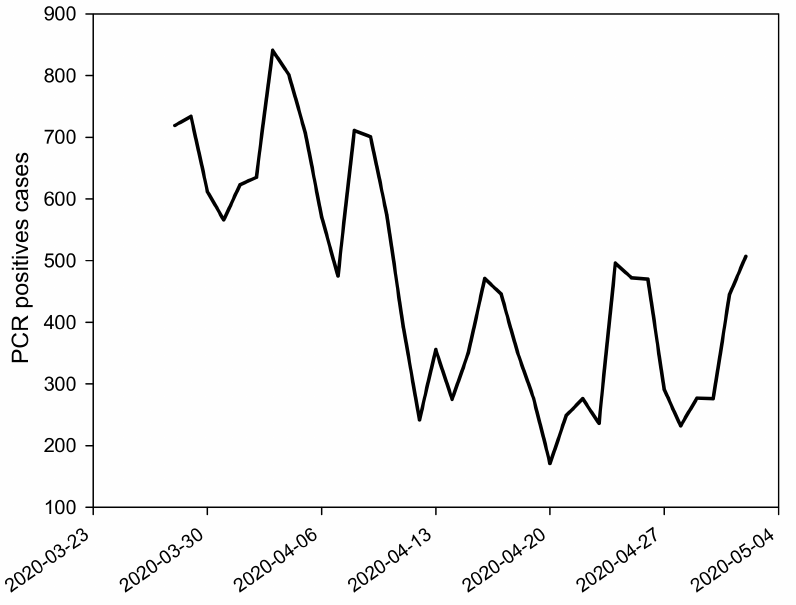
Figure 2. Number of positives cases with a PCR test in Castilla-La Mancha between 16 March